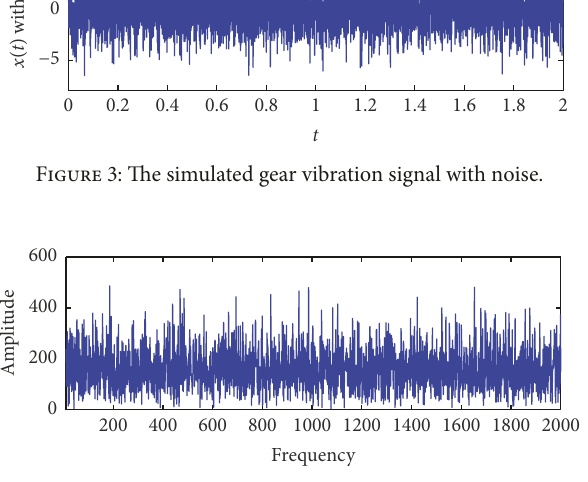
Figure 4: The FT of the simulated gear vibration signal with noise.